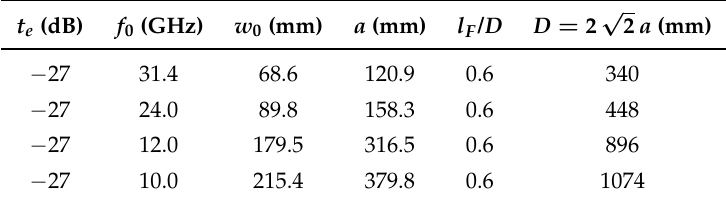
Table 3. Main reflector